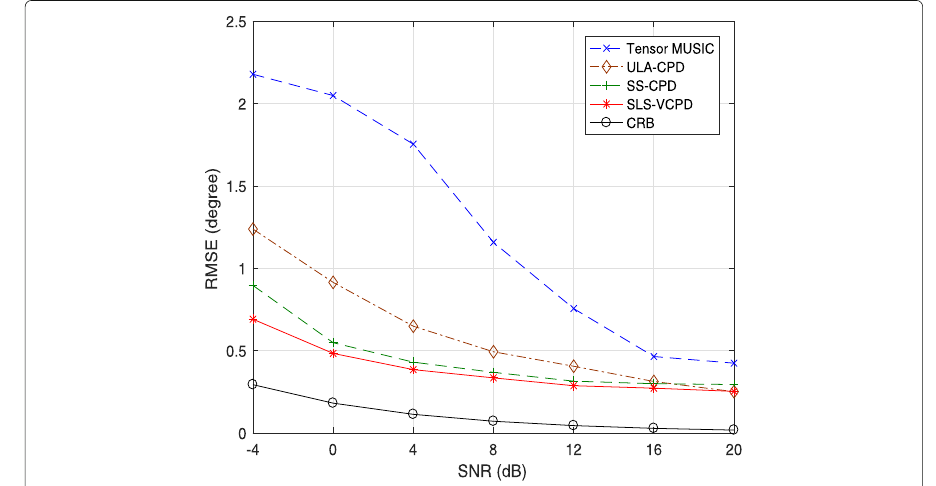
Fig. 8 RMSE versus SNR for two sources with M = 6 and T =